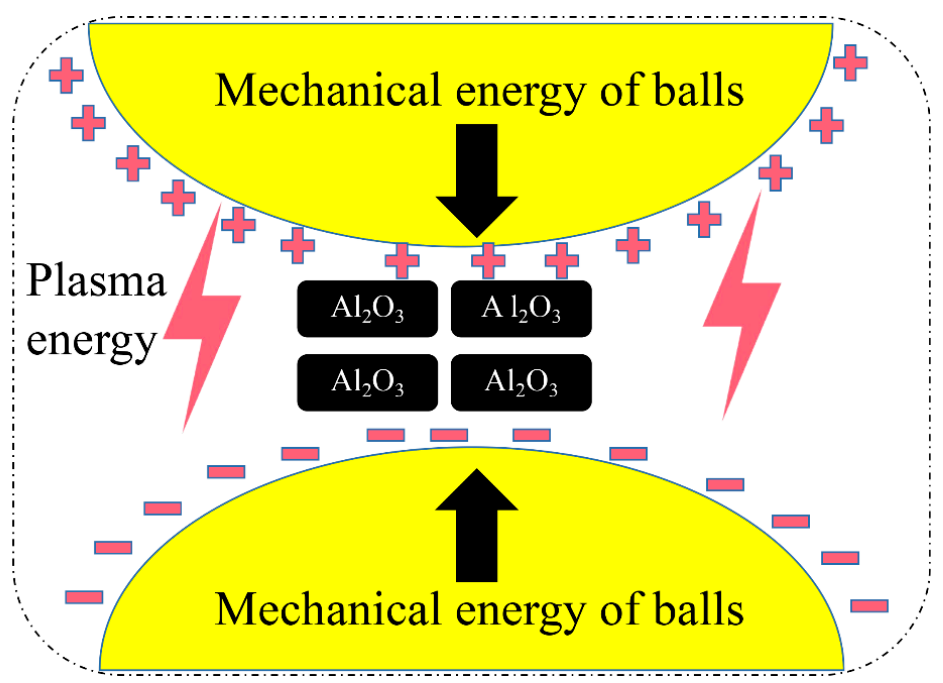
Figure 10. Schematic diagram of DBDPM activation mechanism on Al 2 O 3 powder.